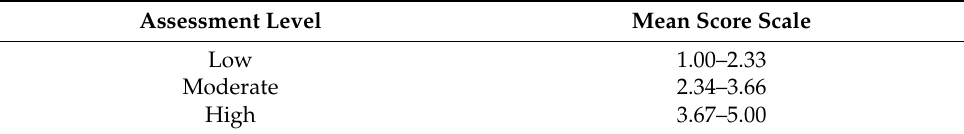
Table 4. Cutoff Point Levels of Each